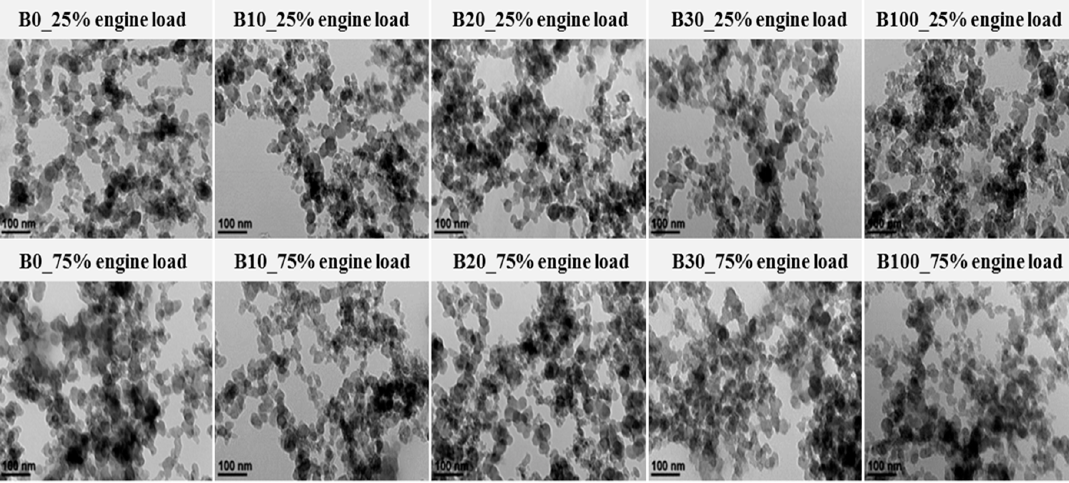
Figure 7. Photograph of filter papers covered with particles ( a ), and the color depth of the filter papers ( b ).